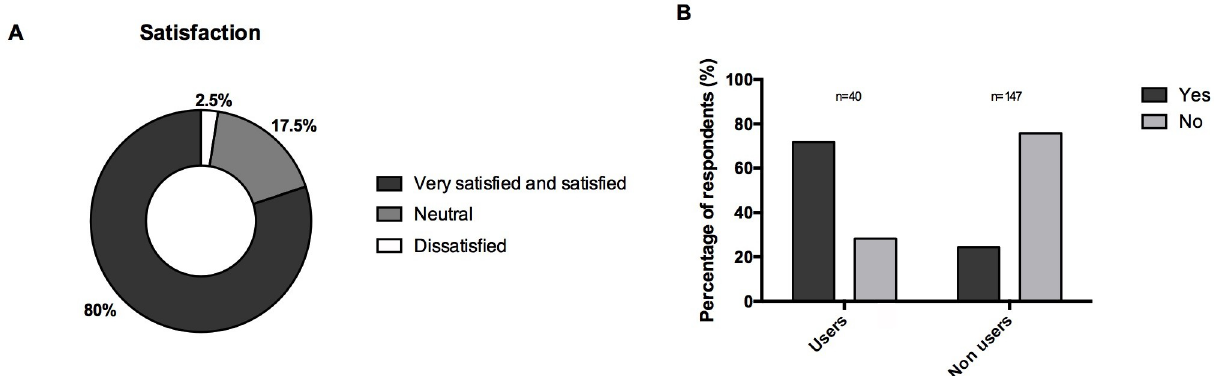
Fig 6. (A) Overall satisfaction of respondents who had a device suitable for inhaled sedation available in their intensive care unit regarding the use of inhaled sedation. (n = 40) (B) Answers to the question « Do you think that inhaled sedation is an interesting alternative to intravenous sedation in the intensive care unit? » by users and non-users of the technique. (n = 187) Data are represented in %